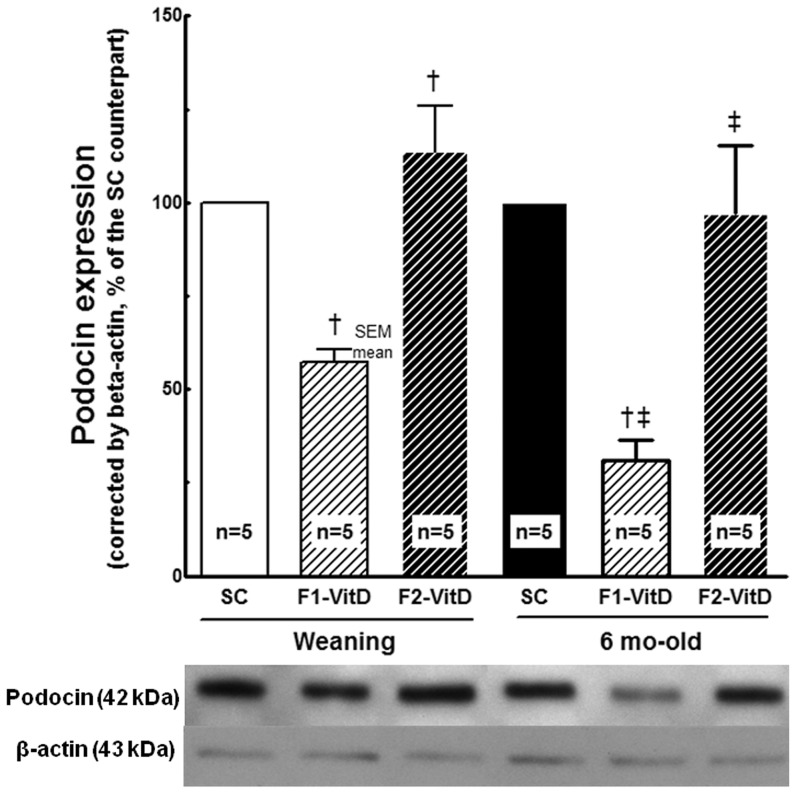
Western blotting analysis of renal tissue at weaning and 6 months of age for podocin expression.The average values were measured and equal protein loading was confirmed by probing blots with beta-actin antibody and is expressed as a percentage of the SC counterpart. Data are reported as means ± SEM; P<0.05, one-way ANOVA and post-hoc of Tukey's test: † compared to SC counterpart; ‡ compared to F1 generation.